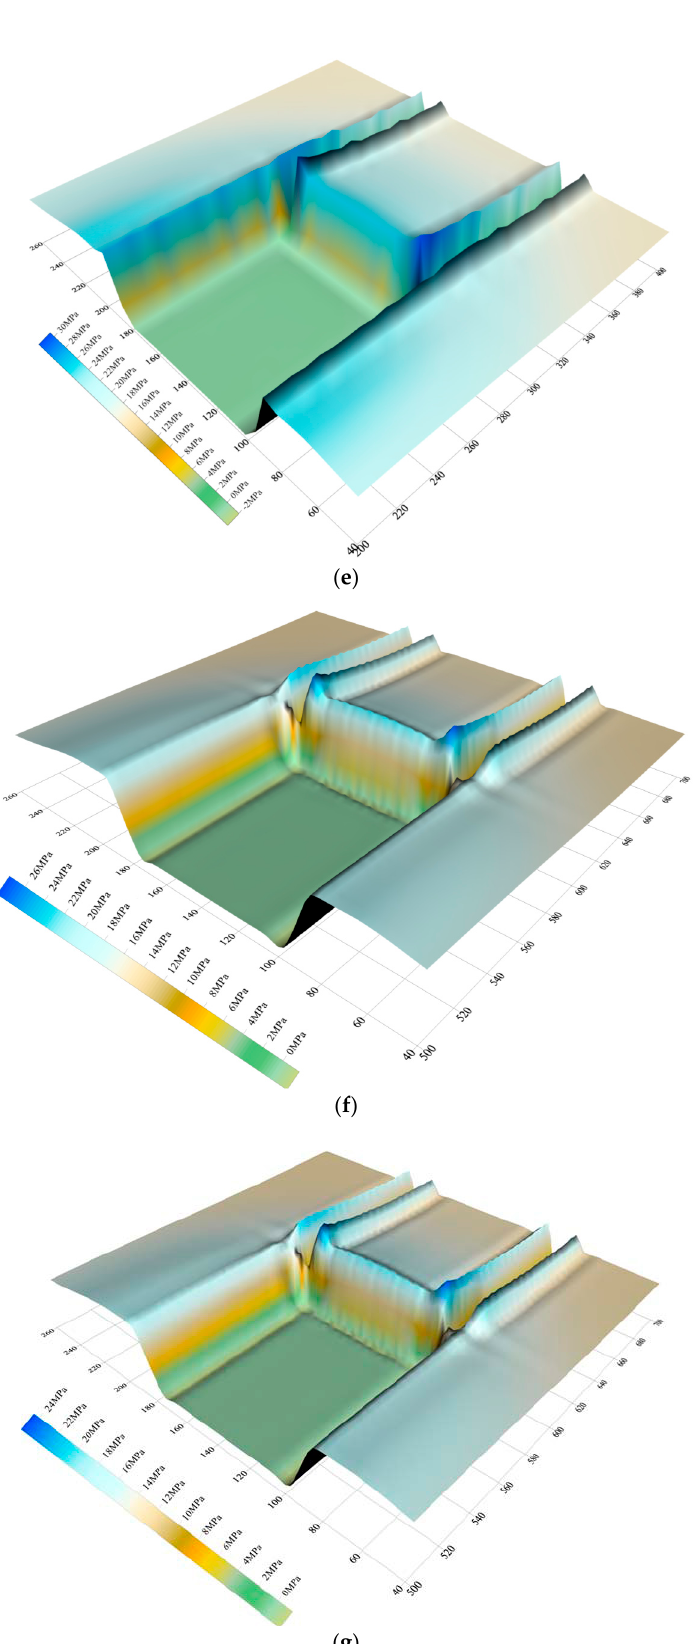
Figure 8. Distributions of advanced abutment stress for different roof-controlled backfill ratios: ( a ) 0%; ( b ) 40%; ( c ) 60%; ( d ) 82.5%; ( e ) 91%; ( f ) 93%; and ( g ) 97%.